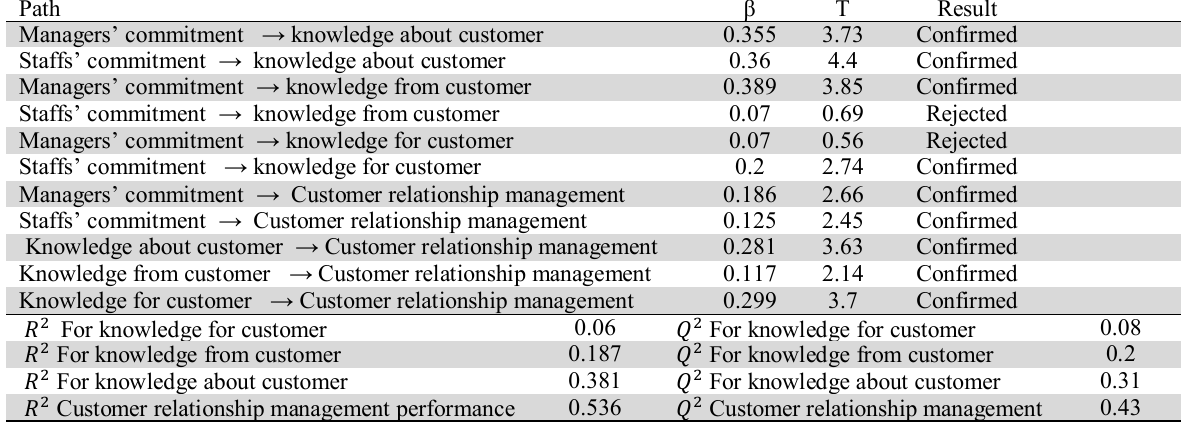
Coefficients of conceptual model